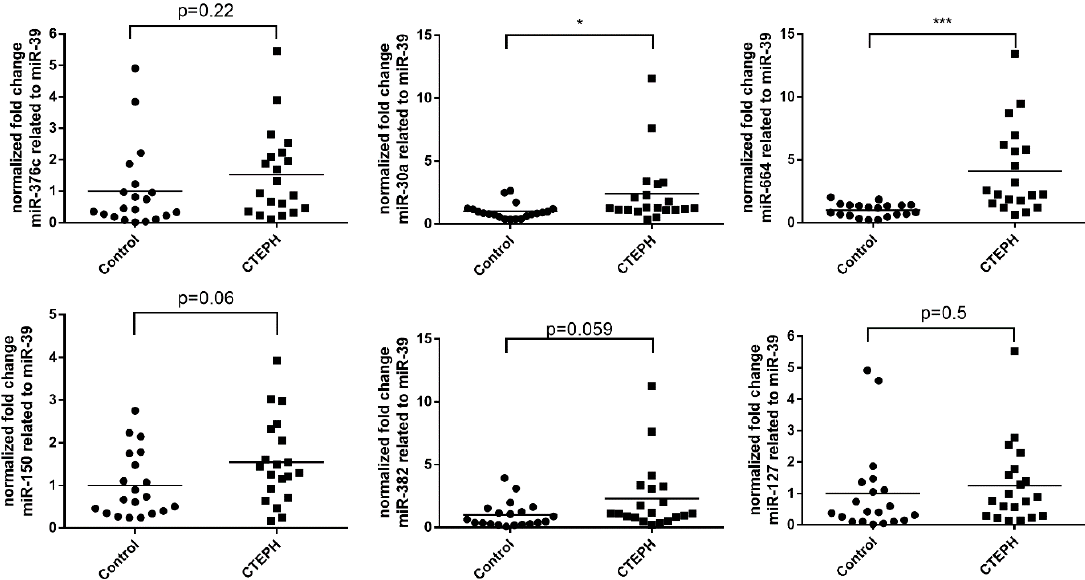
Figure 3. EV-associated miRNA abundance in serum of CTEPH patients (n = 20) and healthy controls (n = 20). EVs were isolated by the total exosome isolation (TEI) method and associated miRNAs were isolated using the ExoEasy protocol. miRNA abundance was standardized to the spike-in control cel-miR-39 and compared with that of control individuals. Lines represent mean values. Significance was calculated using Student’s t-test with Welch’s correction. * p < 0.05, ** p < 0.01, *** p < 0.001.